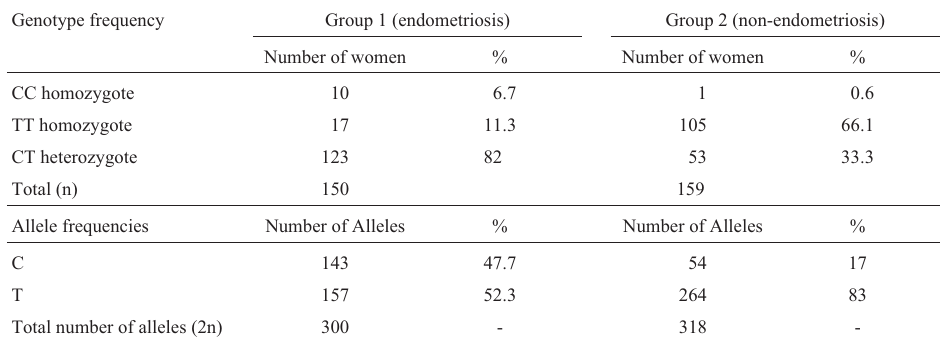
Table 1 - Genotype and allele frequencies of the CDH1 gene 3’-UTR cuttable (C) and uncuttable (T) polymorphism in women with and without endometriosis. The differences in homozygote genotype and allele frequencies between the two groups were significant at p = 0.0001 by the chi-squared